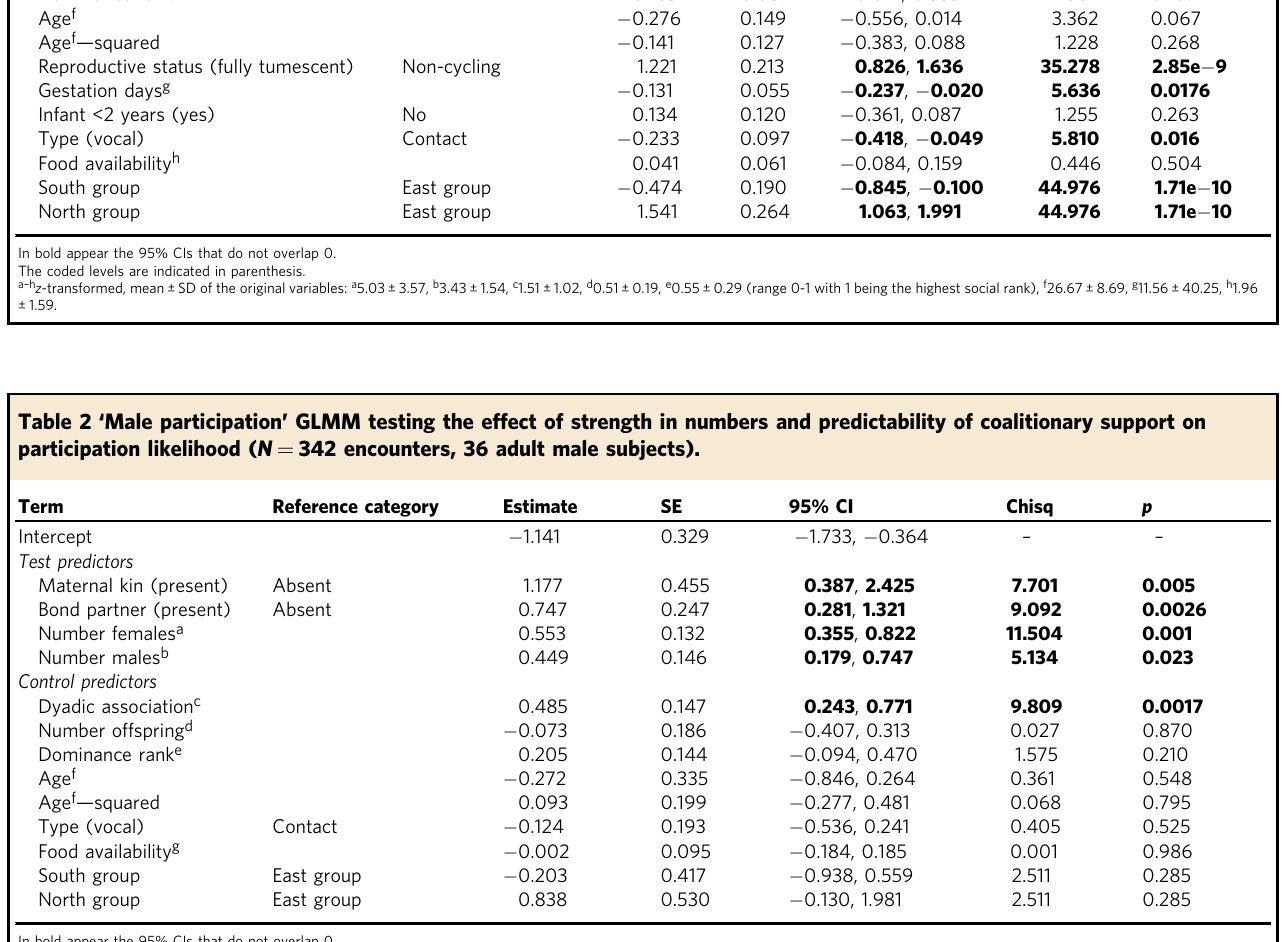
Table 1 ‘ Female participation ’ GLMM testing the effect of strength in numbers and predictability of coalitionary support on participation likelihood ( N = 343 encounters, 75 adult female subjects).